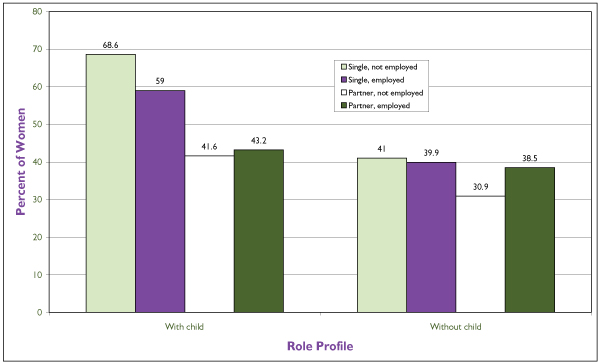
Percent Reporting High Personal Stress for Women in Role Profiles, Canada, NPHS, 1994–1995